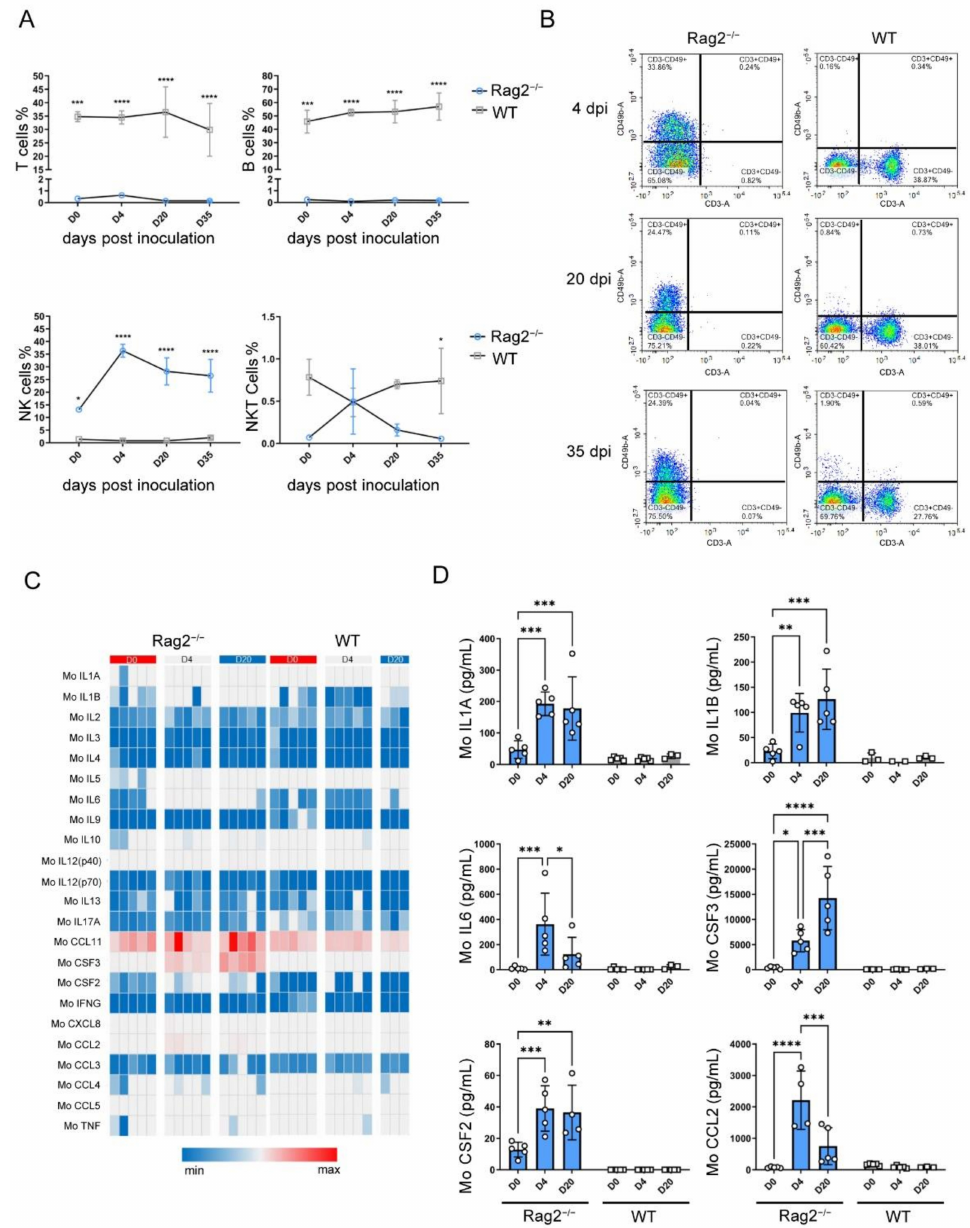
Figure 4. Abundance of immune cells and inflammatory response in Rag2 − / − mice during hRSV infection. ( A ) Comparison of the contents of T, B, NK and NKT cells in Rag2 − / − and wild-type mice on various time points following hRSV infection. The statistical significance was evaluated using two-way ANOVA. * p < 0.05, *** p < 0.001, **** p < 0.0001 ( B ) The abundance of NK cells in a representative homozygous Rag2 − / − mouse at 3 time points after infection. A total of 23 cytokines were quantified using the Bio-Plex Pro Mouse Cytokine 23-plex Assay kit. ( C ) Heat map of peripheral blood cytokine concentration (pg/mL) of Rag2 − / − and wild-type mice on 0, 4, and 21 dpi after infection. The relative concentration of 23 cytokines were showed from the blue (low) to red (high). ( D ) The expression of IL1A, IL1B, IL6, CSF3(G-CSF), CSF2(GM-CSF), and CCL2(MCP-1) at each time point of hRSV infection. The statistical significance was evaluated using two-way ANOVA. * p < 0. 05, ** p < 0. 01, *** p < 0.001, **** p < 0.0001. In addition to detecting immune cells, a total of 23 cytokines in the sera of Rag2 − / − and wild-type infected mice were quantified using the MSD method [27]. Most expression of cytokines including IFNG did not change significantly after hRSV infection in Rag2 − /